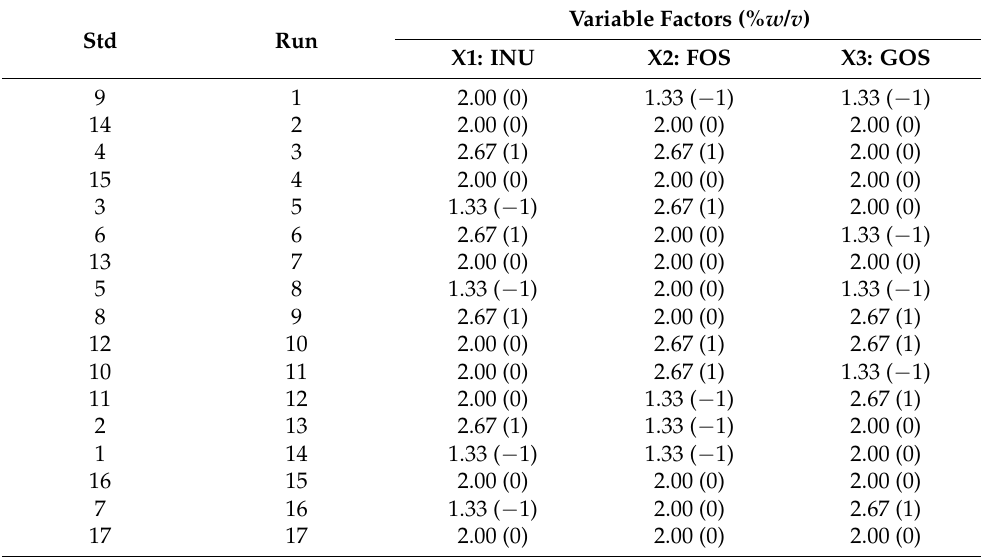
Table 1. The content and code of an independent variable on a Box–Behnken design (BBD) for PI score and total short chain fatty acids